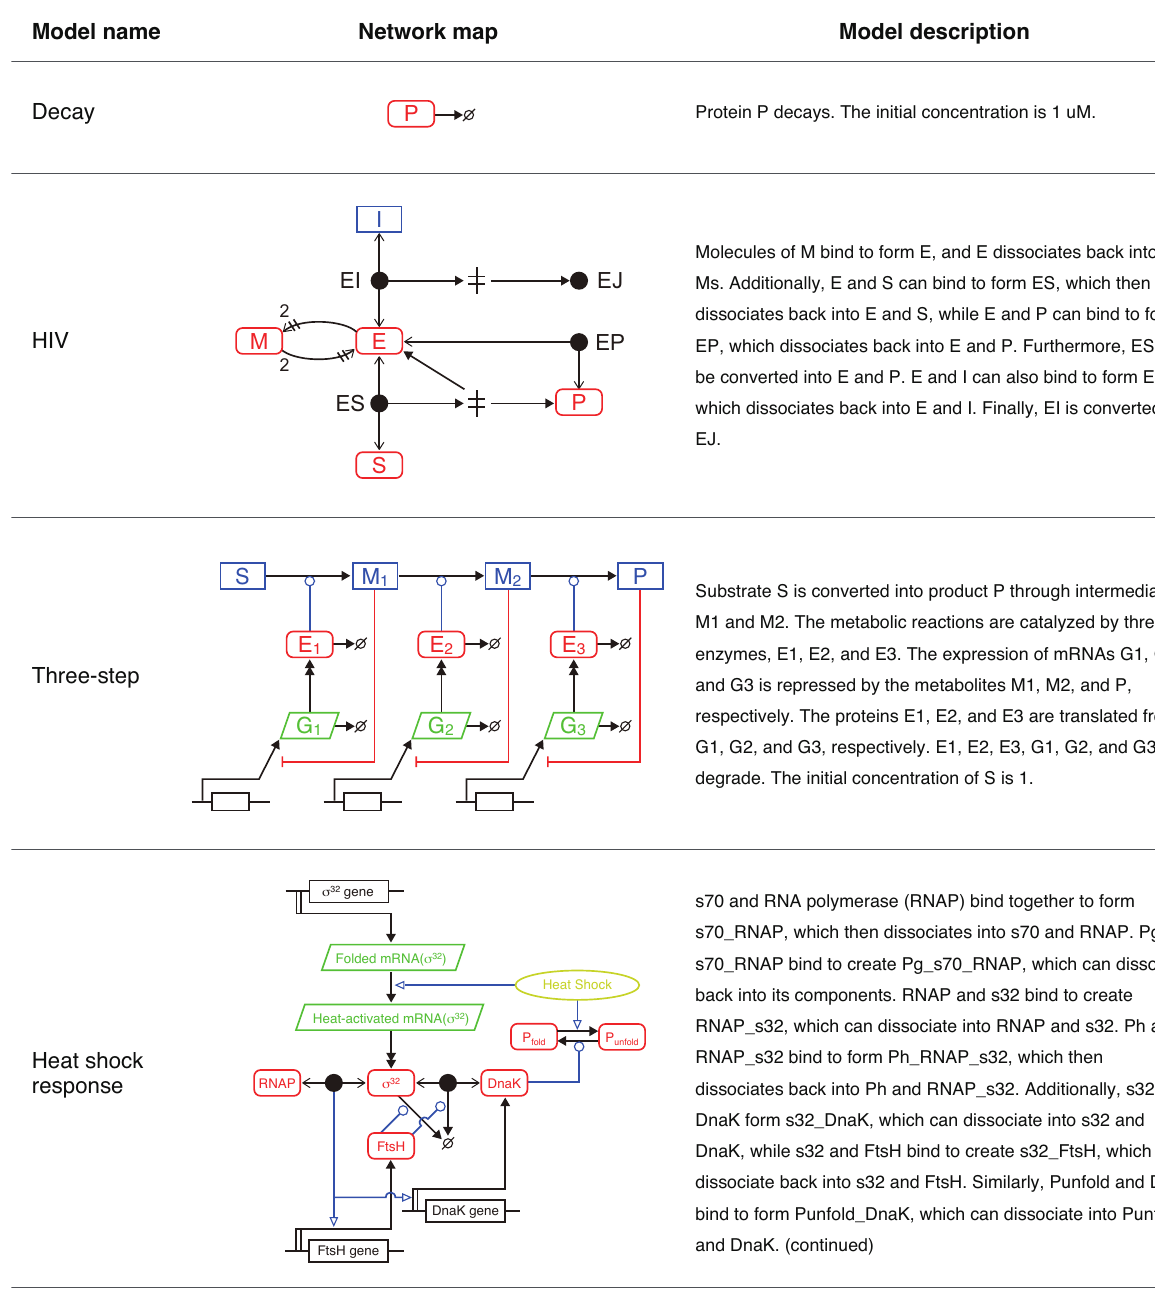
Figure 1. Test problems. We tested whether KinModGPT can create SBML models from the natural language model descriptions. For the reaction network maps, CADLIVE notation was used [9–11]. For simplicity, only important reactions are shown in the reaction network map for the heat shock